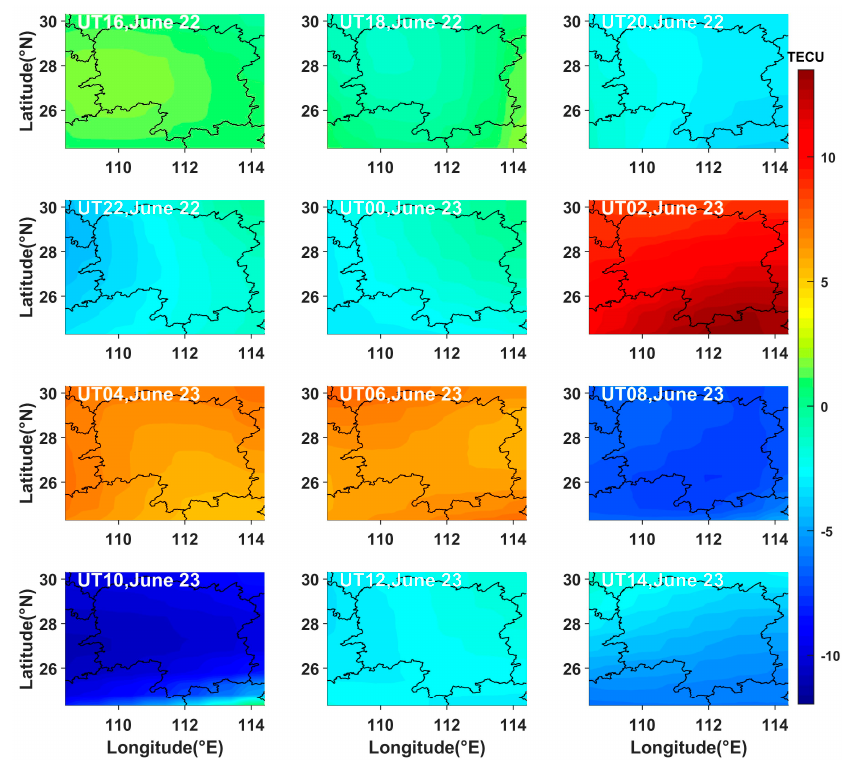
Figure 11. Time-series variation of differential total electron content on June 22 and 23, 2015.